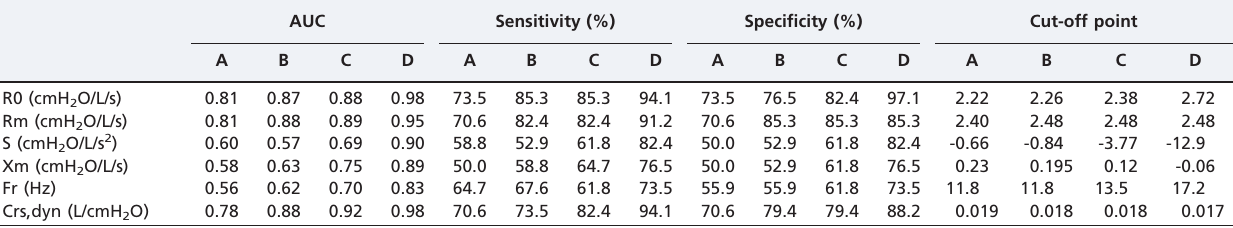
Table 4 - Values of area under the ROC curve (AUC), sensitivity and specificity for the optimal cut-off point for the FOT